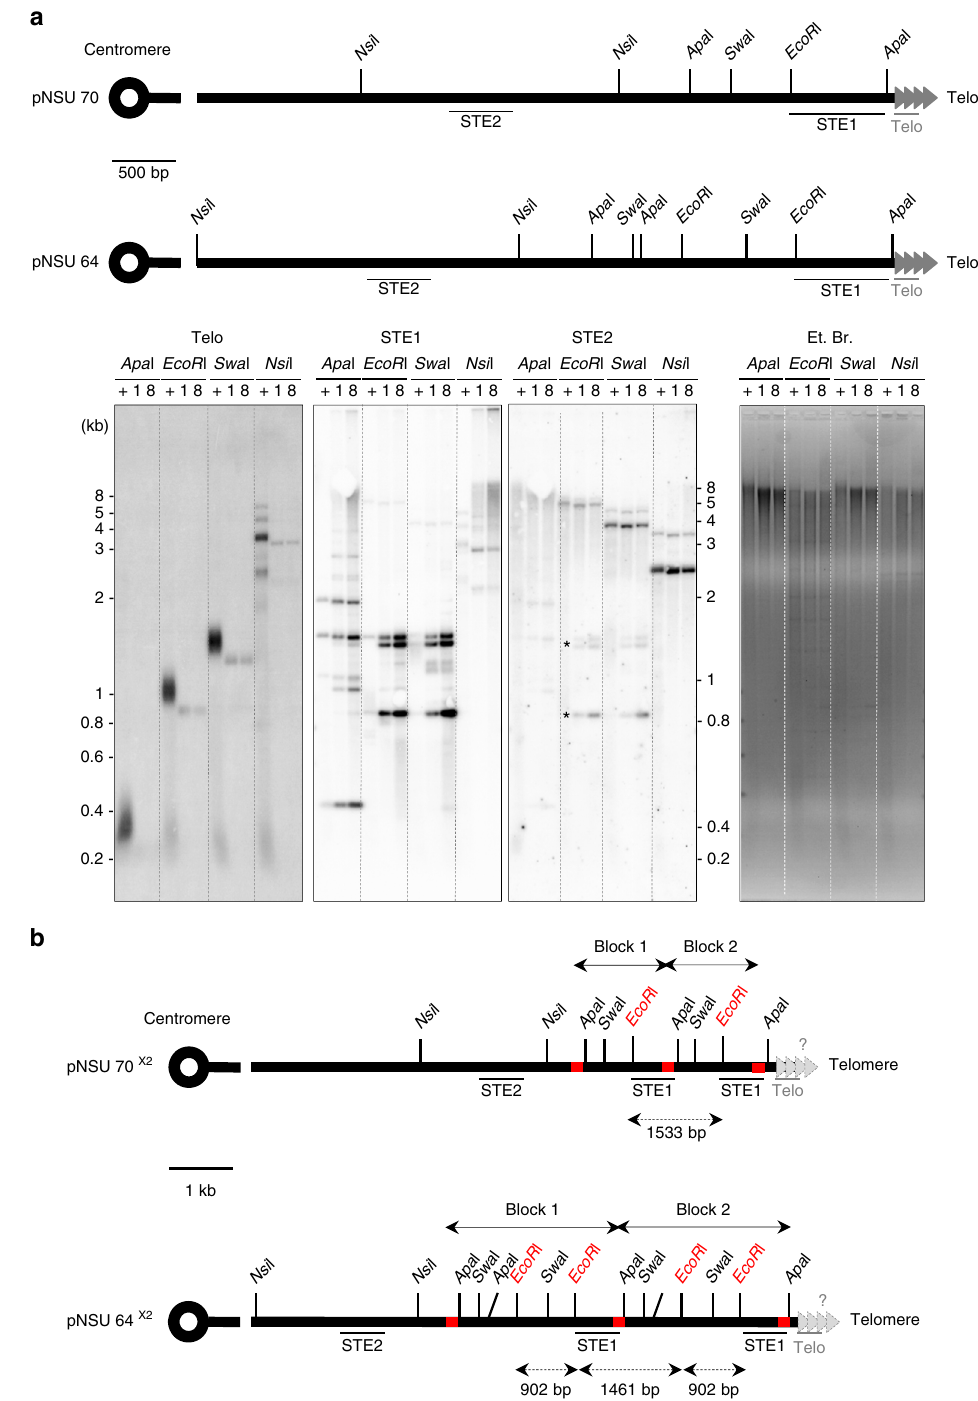
Fig. 2 Subtelomeric rearrangements in quiescence correspond to duplication of a STE1-extended region. a Top, relative position of the restriction sites in the telomeric and subtelomeric regions within pNSU70 and pNSU64. Both pNSU64 and pNSU70 are representative plasmids that share signi fi cant restriction pattern similarity with pNSU65/pNSU21 and pNSU77/pNSU71, respectively 29 . The position of telomeric (Telo) and subtelomeric probes (STE1 and STE2) used for southern blot are represented. Bottom, genomic DNAs from quiescent cells ( ter1 +, after 8 days in G0 (+)) and ter1 Δ cells (after 1 and 8 days in G0 (1 and 8)) were digested by Apa I, EcoR I, Swa I and Nsi I, and southern blotted. The membrane was hybridized with either Telo, STE1, or STE2 probes, as indicated. Ethidium bromide staining DNA was used as a loading control. Asterisks represent the residual signal from STE1 probe. b Schematic representation of an Apa I – Apa I subtelomeric duplication. STE1-Extended region (STEEx) within subtelomeric region of pNSU70 and pNSU64 (pNSU70 ×2 and pNSU64 ×2 ). According with this scheme, EcoR I digestions of pNSU64 ×2 and pNSU70 ×2 generate two DNA fragments of 902 and 1461 bp, and a single DNA fragment of 1533 bp, respectively. These three DNA fragments correspond to the bands that accumulated during quiescence at eroded telomeres. The presence of telomeric repeats at STEEx ends is not